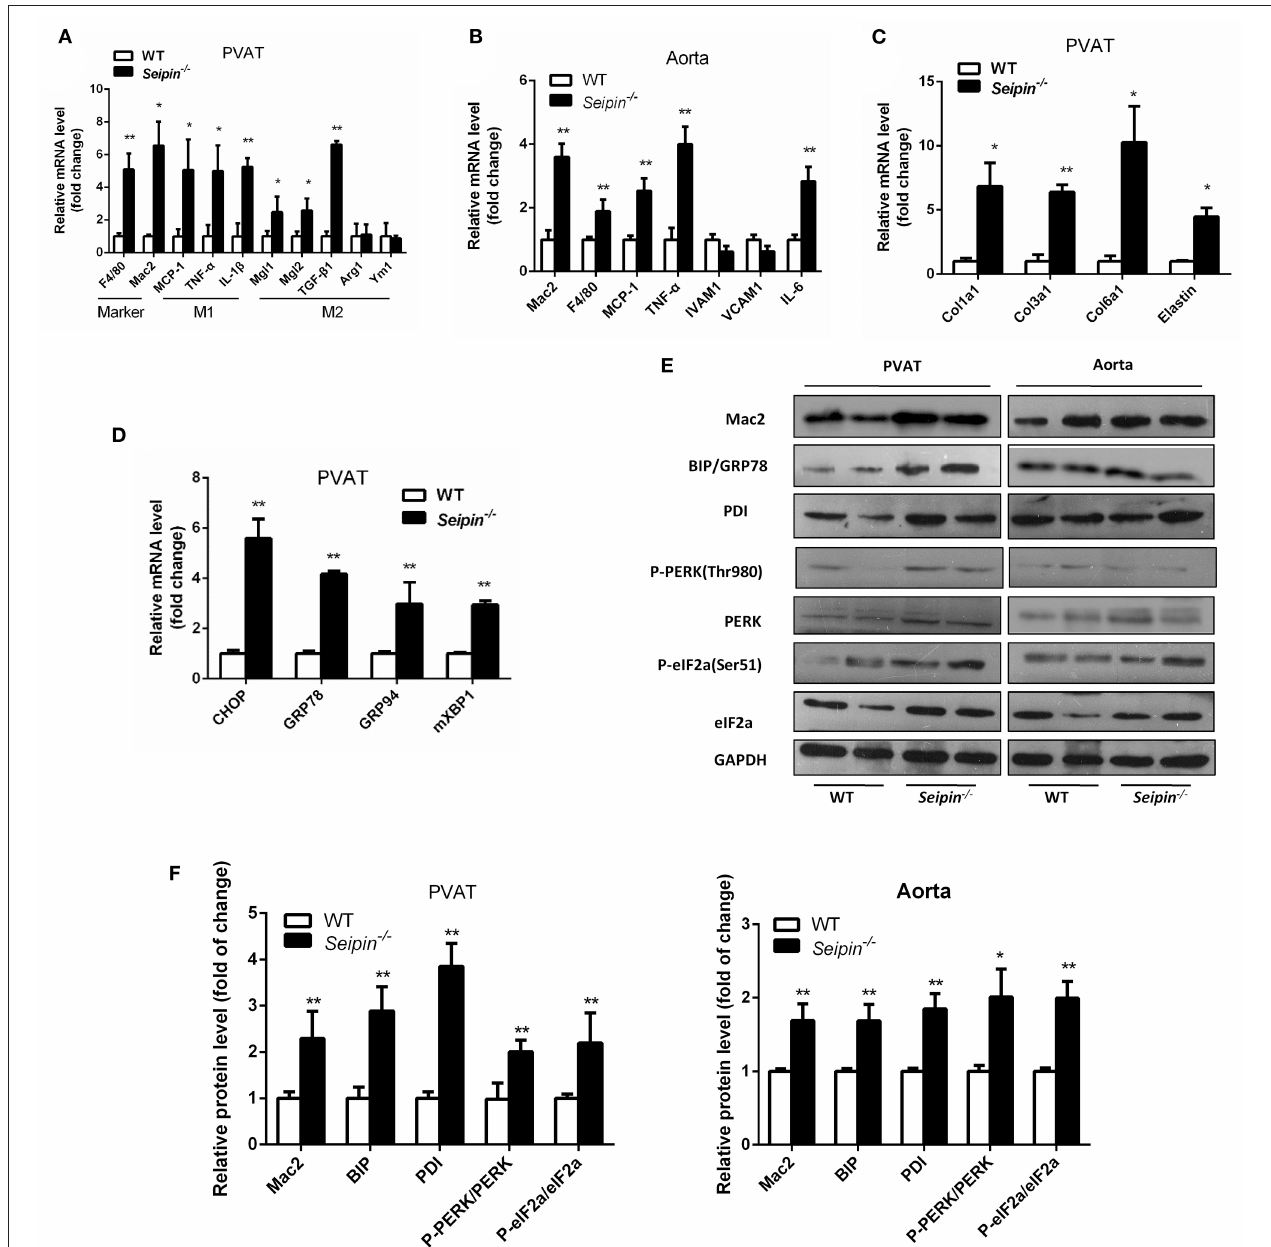
FIGURE 4 | Inflammation, fibrosis and ER stress gene expression in PVAT and aorta from WT and Seipin − / − mice. Relative mRNA levels of macrophages and inflammatory cytokines (A,B) , fibrosis (C) , and ER stress (D) in PVAT and aorta from 6-month-old WT and Seipin − / − mice. N = 6. (E,F) Western blot images and densitometric quantitation for the indicated proteins and phosphoproteins related to inflammation and ER stress in PVAT from WT and Seipin − / − mice. Data are expressed as mean ± SEM. N = 6, * P < 0.05, ** P < 0.01 for Seipin − / − mice vs. WT.